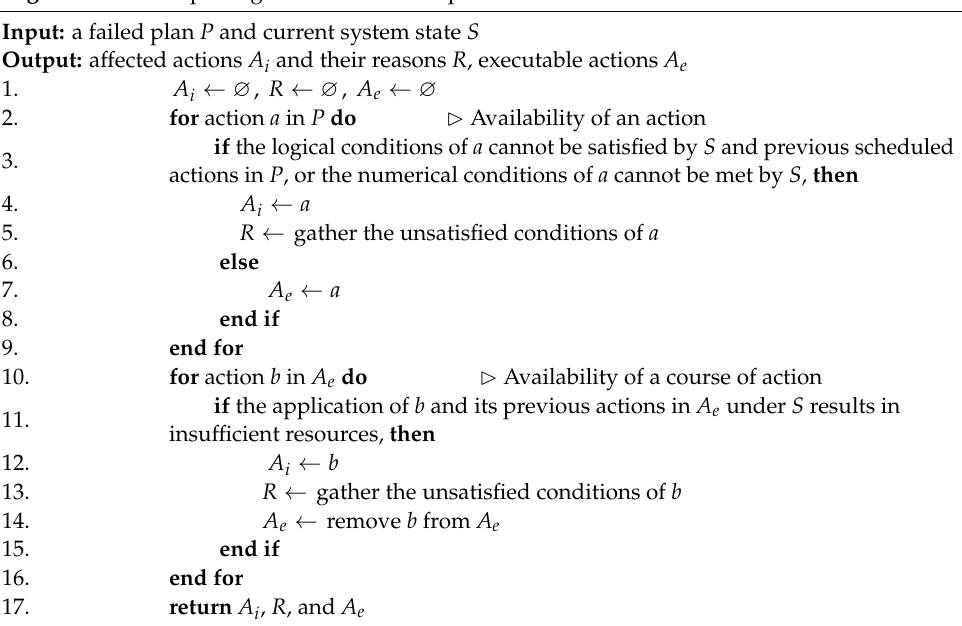
Algorithm 1 Bi-loop recognition of defective planned